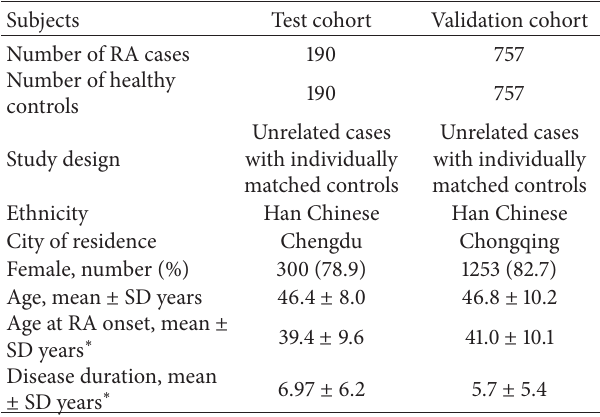
Table 2: Clinical characteristics of the test and validation